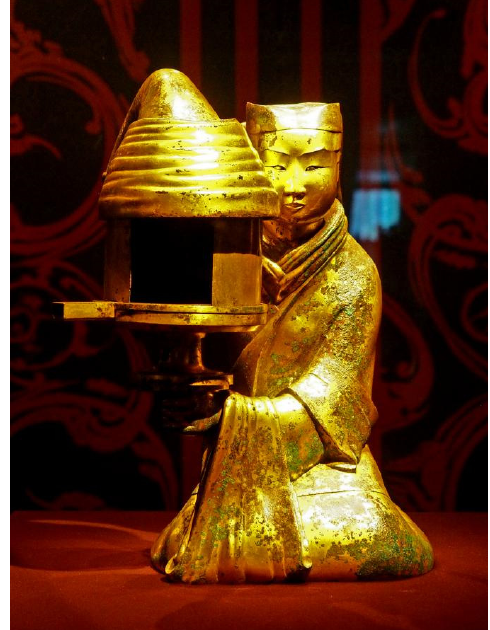
Figure 4. Gilded bronze human-shaped lamp from the Western Han Dynasty. Displayed in the Museum of Hebei Province. Photograph taken by the author.